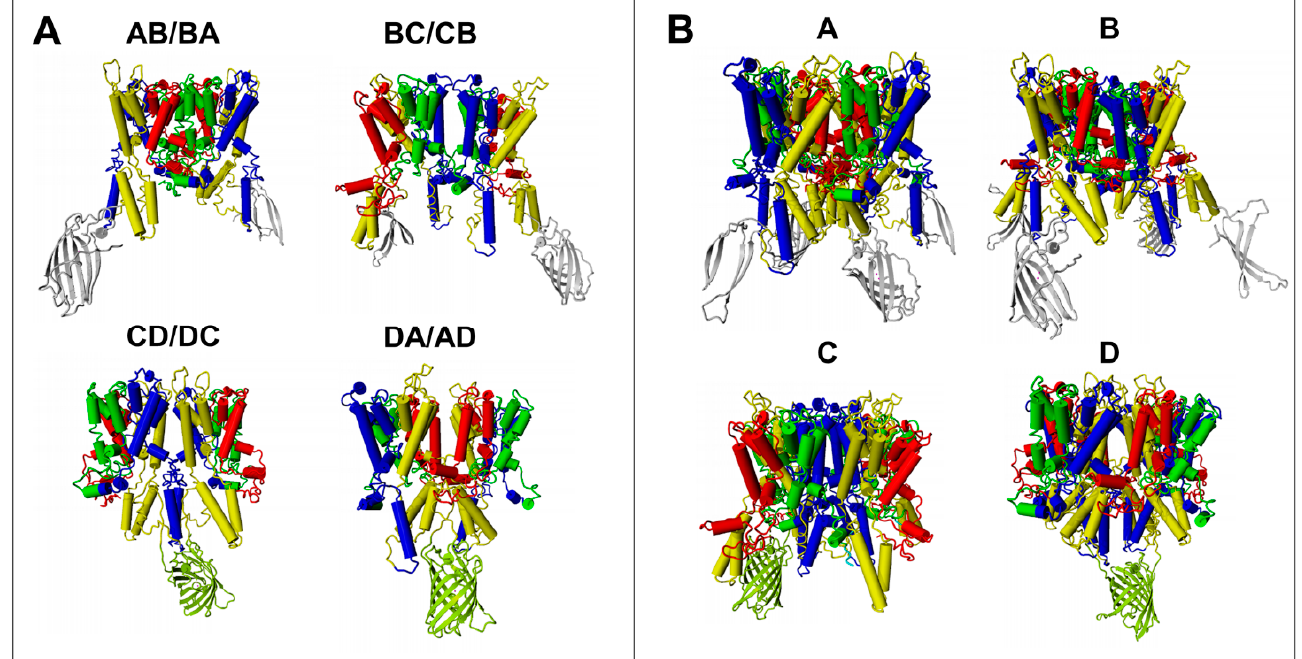
Figure 4, the models for Trk1[ ∆ LHL]/VC and Trk1[ ∆ LHL]/VN (cf. Figure 3) arranged as symmetric dimers or tetramers are shown.